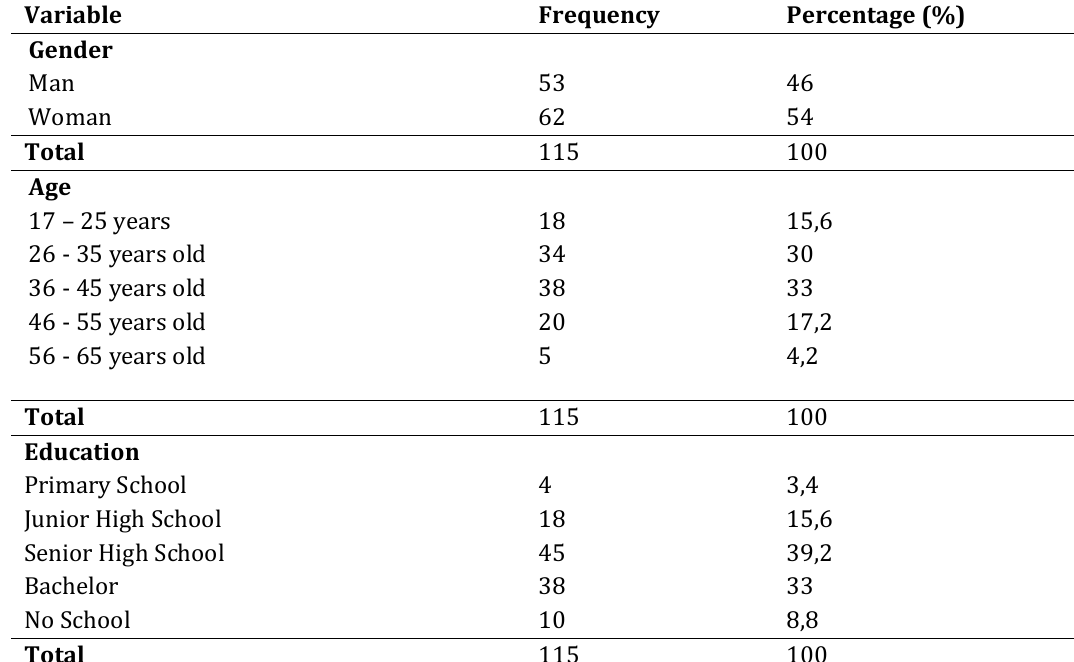
Characteristics of respondents (n = 115)